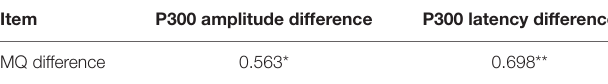
TABLE 4 | Correlation between MQ difference and P300 amplitude or latency difference before and after treatment ( r ).